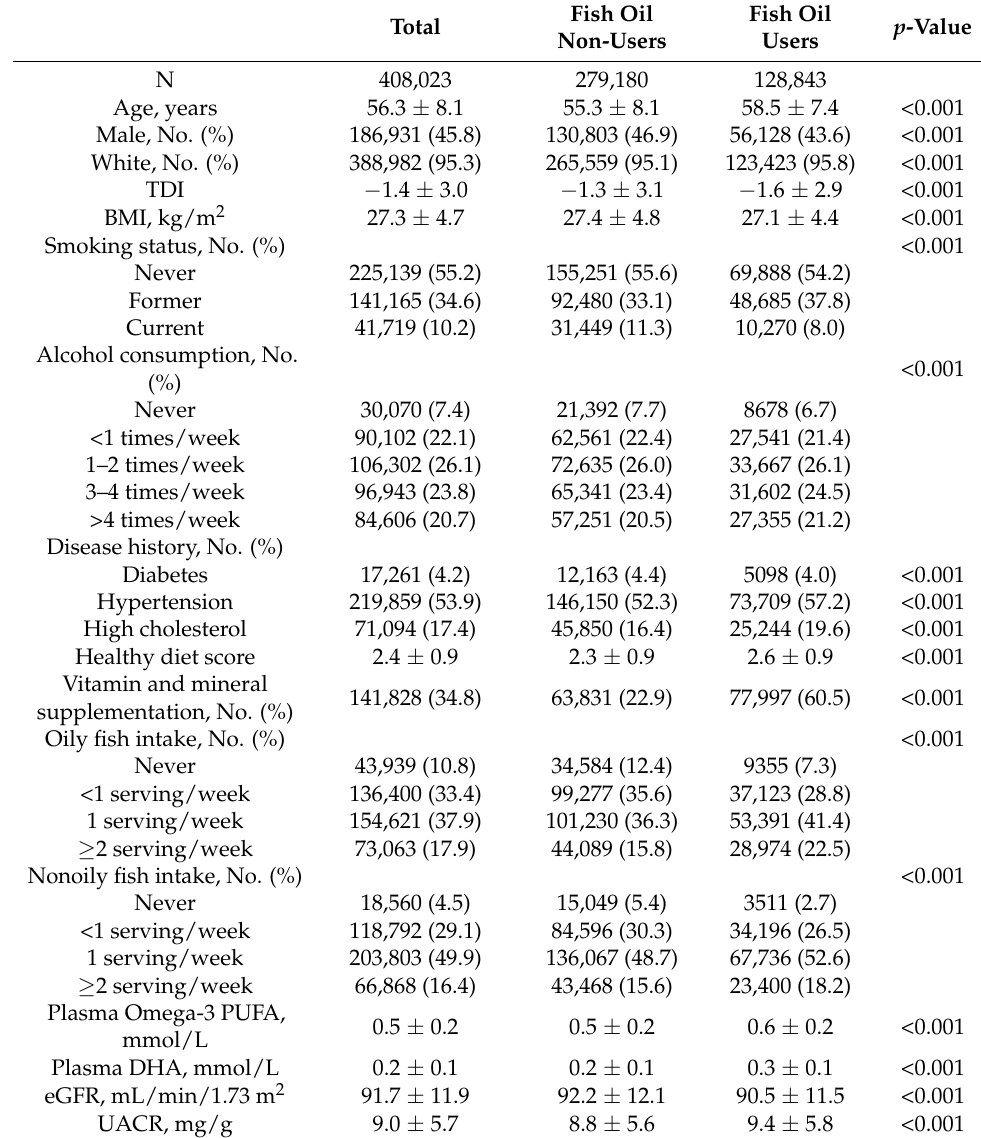
Table 1. Baseline population characteristics by fish oil supplement use